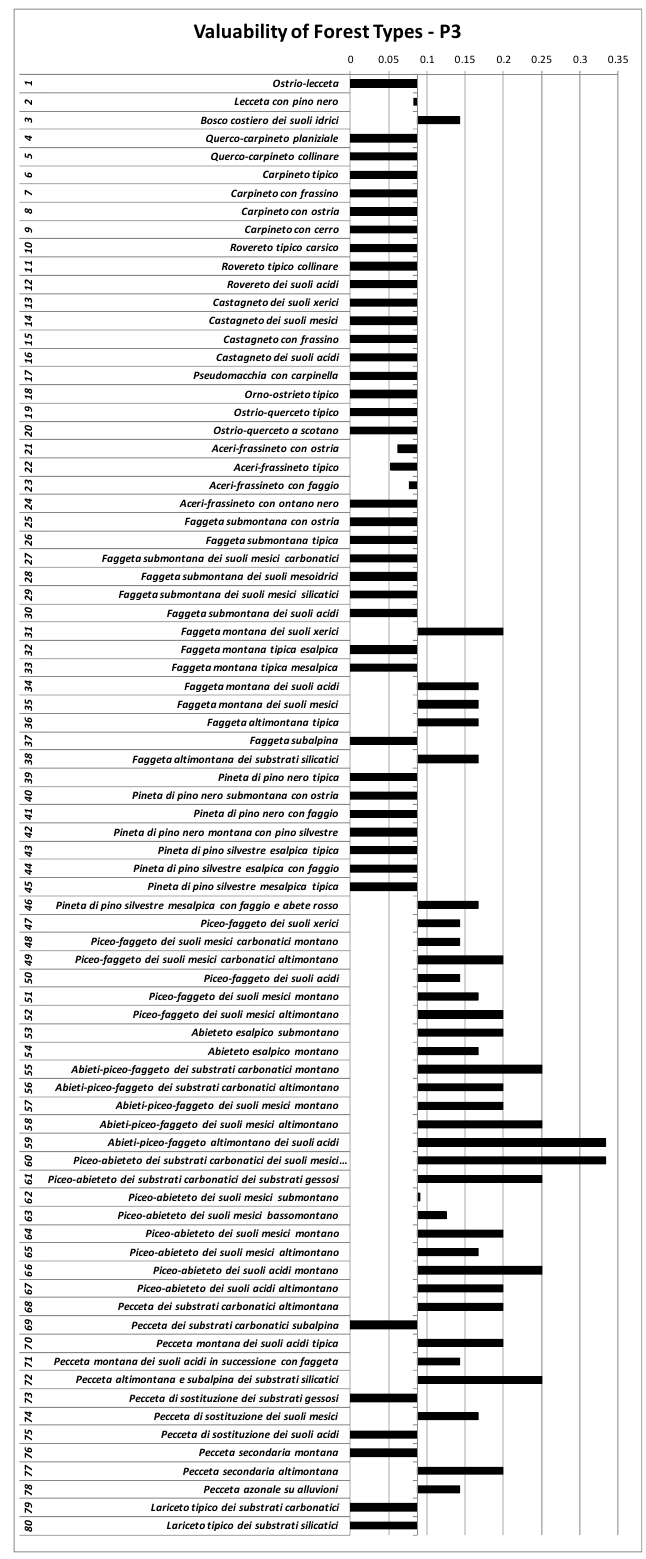
Figure A3. Forest types by increasing altitude. Average P3 value: 0.087064. Below-average = 0; Above-average = 1. Source: